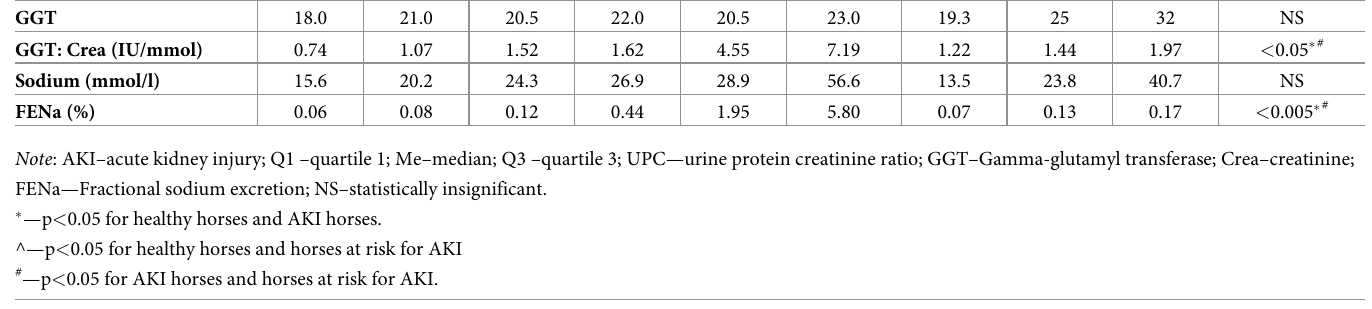
Table 2. Urine biochemistry results of healthy horses, horses with clinical kidney dysfunction (horses with AKI) and horses at risk for acute kidney injury. Parameter Healthy horses (n = 30) Horses with AKI (n = 10) Horses at risk for AKI (n = 30) P